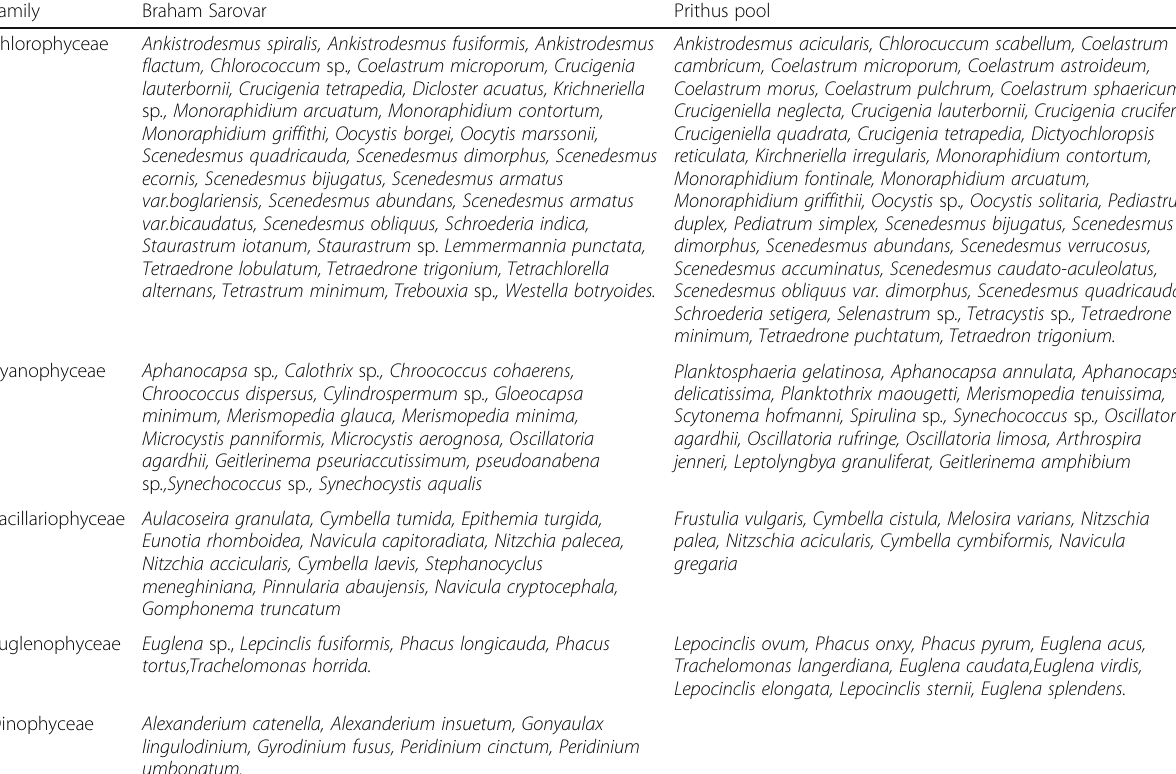
Table 1 List of phytoplankton species observed in Braham Sarovar and Prithus Pools Family Braham Sarovar Prithus pool